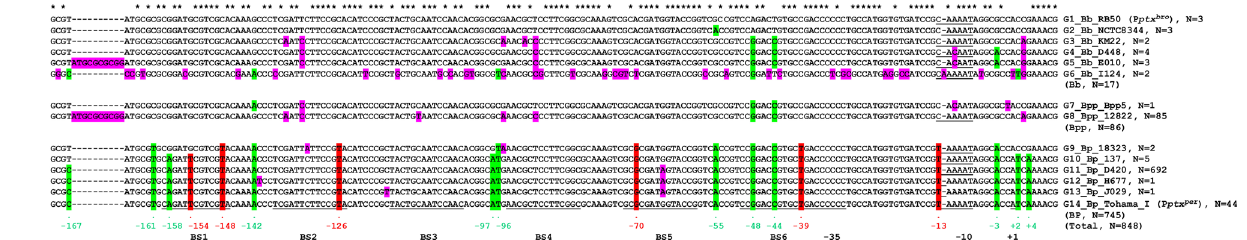
Figure 7. Bordetella P ptx sequence comparison. Different ptx promoter sequences, equivalent to − 170 bp to + 9 relative to the P ptx + 1 of B. bronchiseptica RB50 (genome sequence ID NC_002927.3, nucleotides from 5,198,768 to 5,198,946), were obtained from 848 complete genomes of Bordetella, aligned and grouped based on their sequence as described in “Materials and methods” section. More detailed strain information is available in Table S1. BvgA-binding sites BS1–BS6, and promoter elements − 35, − 10 and + 1 are underlined. Positions in the sequence at which no SNPs were found are marked with an asterisk above the RB50 sequence. SNPs, relative to RB50, shown in this work to contribute to P ptx activation in Tohama I (G14), are highlighted in red and those not shown to so contribute are highlighted in green. Remaining SNPs, or insertions, relative to RB50, present in B. bronchiseptica (Bb), B. parapertussis (Bpp) and B. pertussis (Bp) strains, are highlighted in